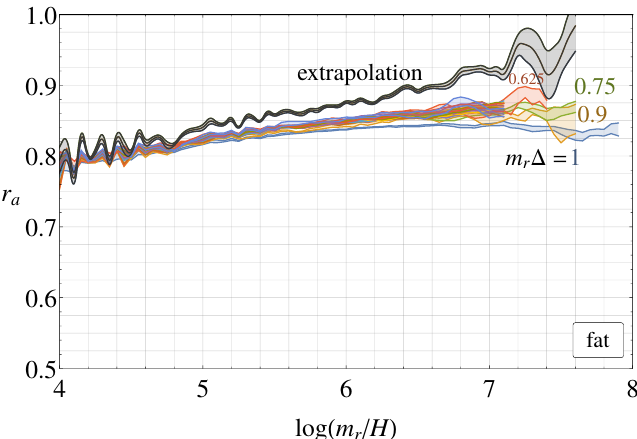
Figure 11: The ratio r between the instantaneous energy emission rate from strings a to axions and the total emission rate (i.e. to both axions and radial modes), as a function of log for different lattice spacings for fat strings. The continuum extrap- olation shows that the network increasingly emits energy to axions (rather than to radial modes) as the log increases. This is consistent with the expectation that heavy modes decouple in the large log